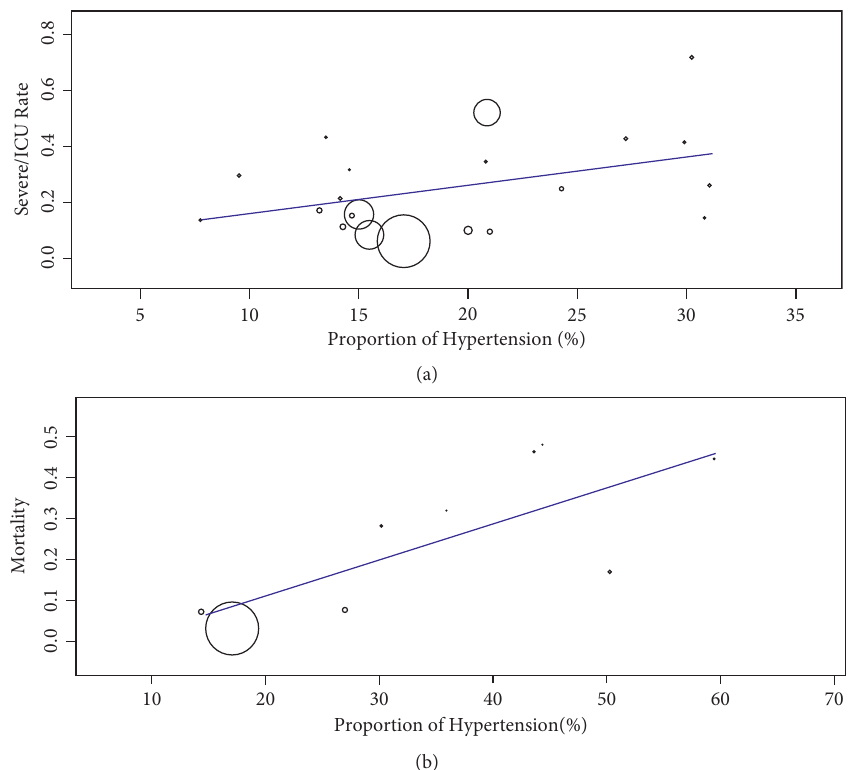
Figure 5: (a) Bubble plots for the association of hypertension with severe/ICU rates in COVID-19 cases. (b) Bubble plots for the association of hypertension with mortality in COVID-19